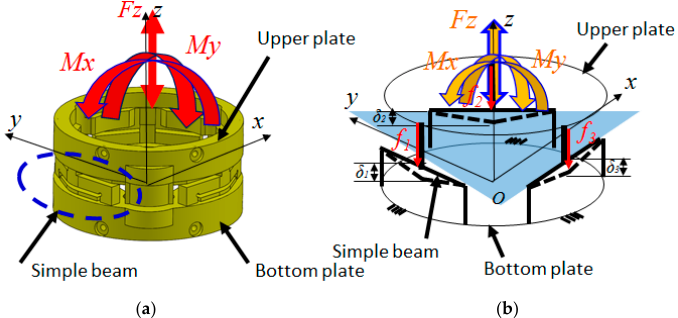
Figure 4. Measurable force and moment components on ( a ) the force/torque sensor and ( b ) simplified sensor structure model (of simply-supported beam).